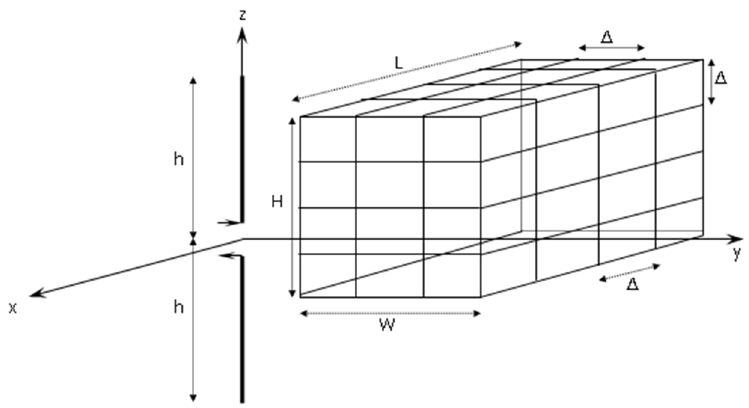
Figure 2. The orientation of a building with reference to the antenna. The building is modeled as a wire-grid rectangular parallelepiped.